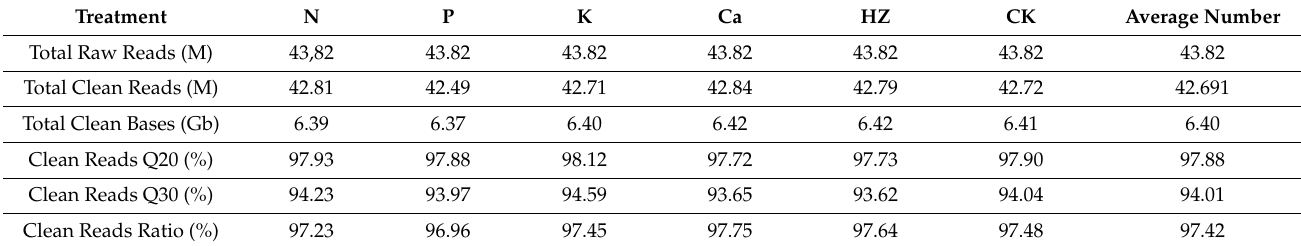
Table 4. Summary of sequencing data of Z. bungeanum transcriptome.